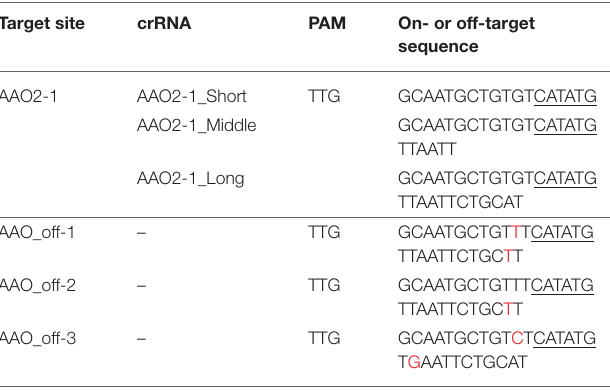
TABLE 3 | Target sequences of AAO2-1 on-target site and off-target candidate site.